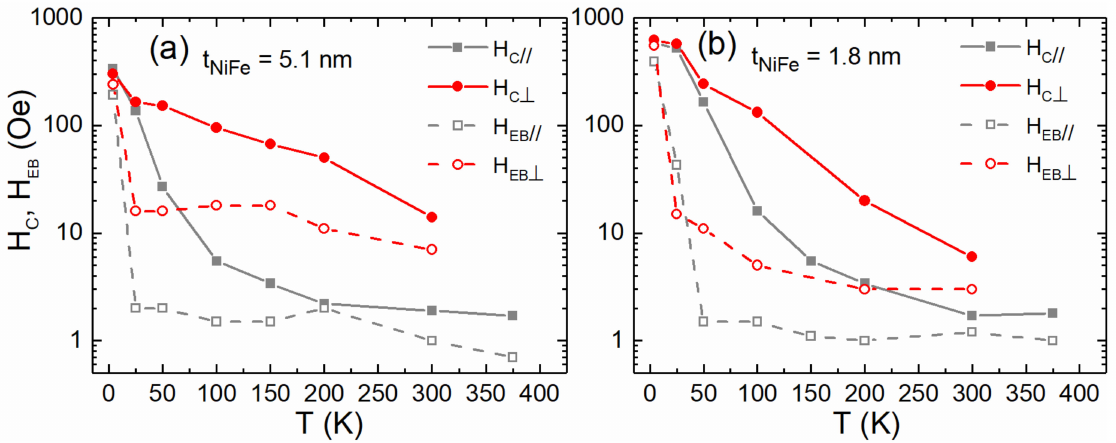
Figure 11. Temperature-dependent coercive and exchange fields for two multilayers with t NiFe = 5.1 nm ( a ) and t NiFe = 1.8 nm ( b ) as